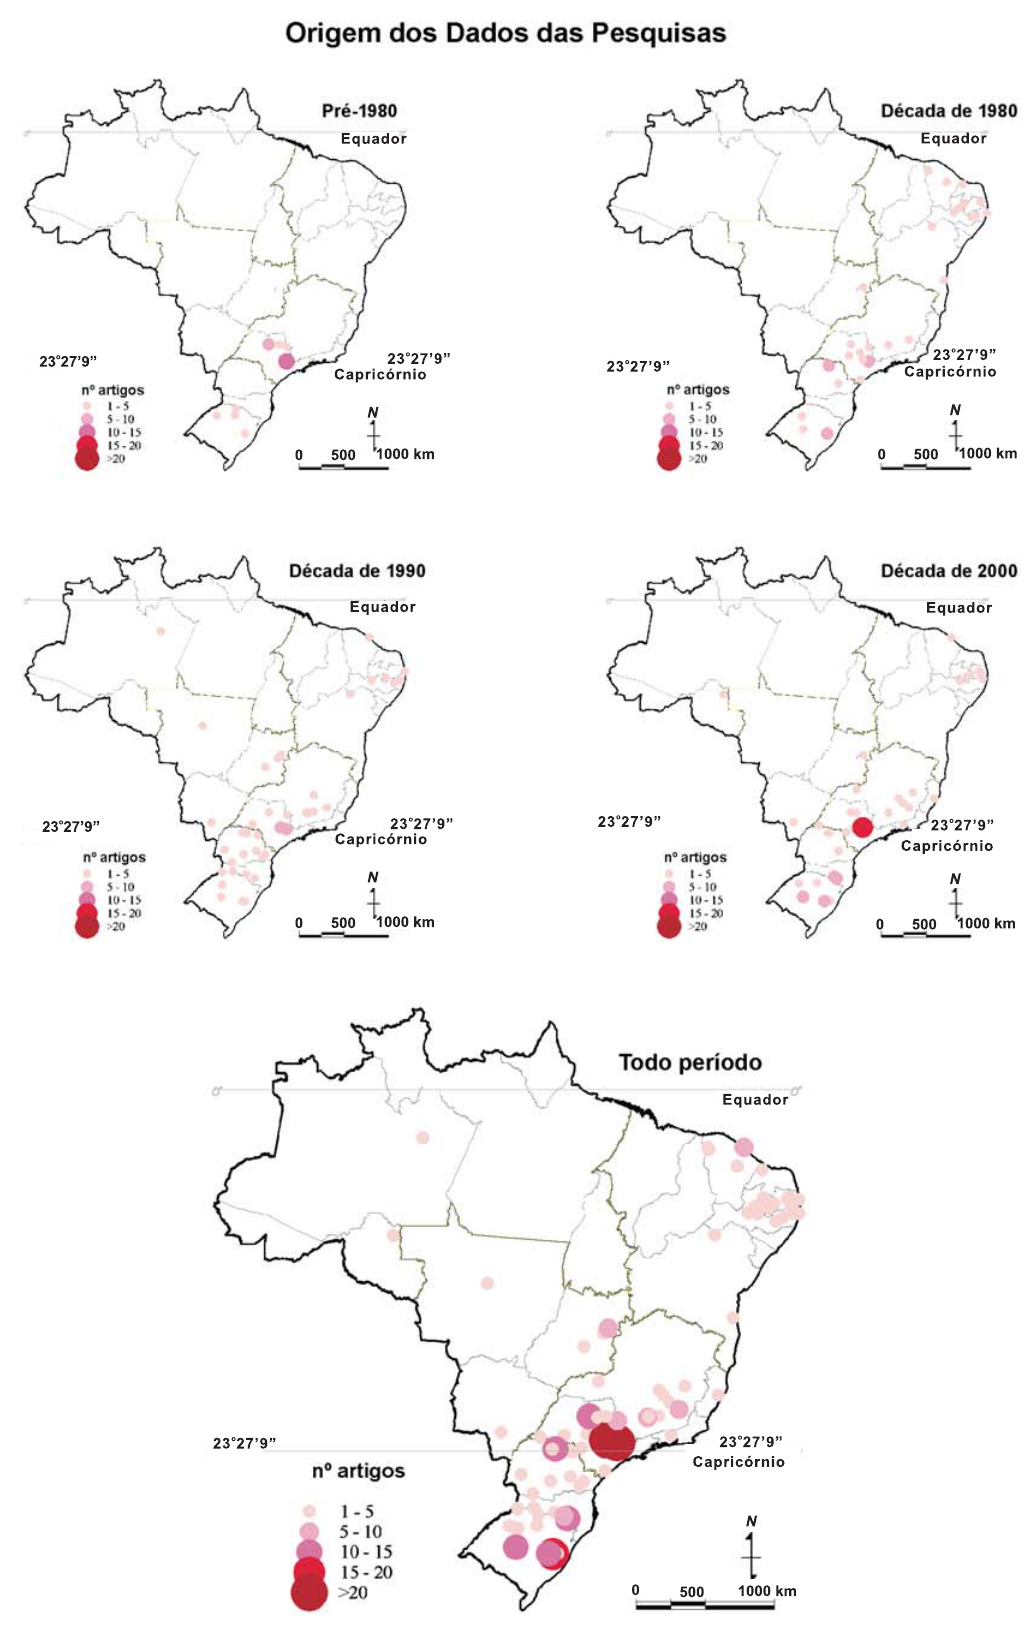
Figura 6. Origem dos dados primários utilizados nas pesquisas sobre erosão do solo no